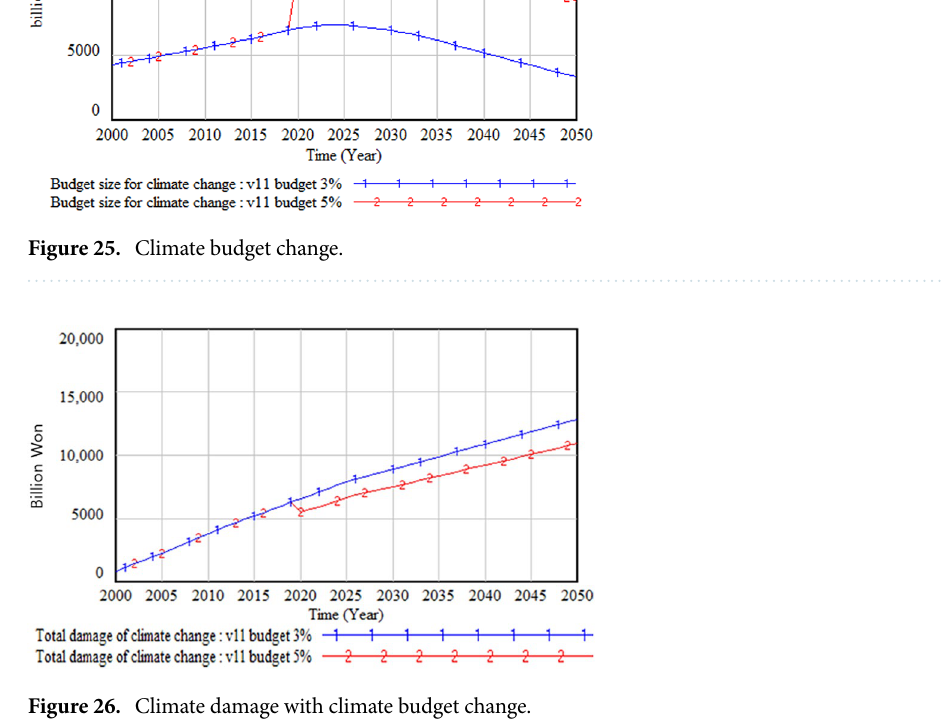
Figure 26. Climate damage with climate budget change.